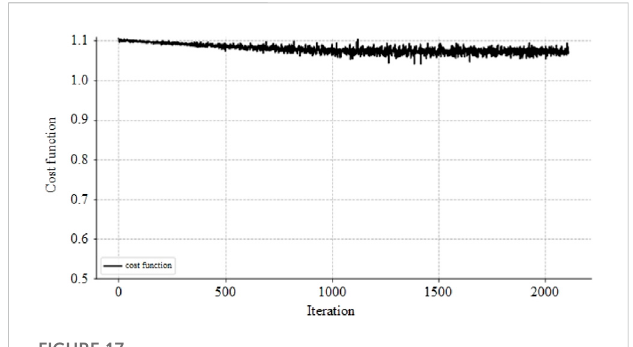
FIGURE 17 Cost function of FFT-LSTM-dropout network.